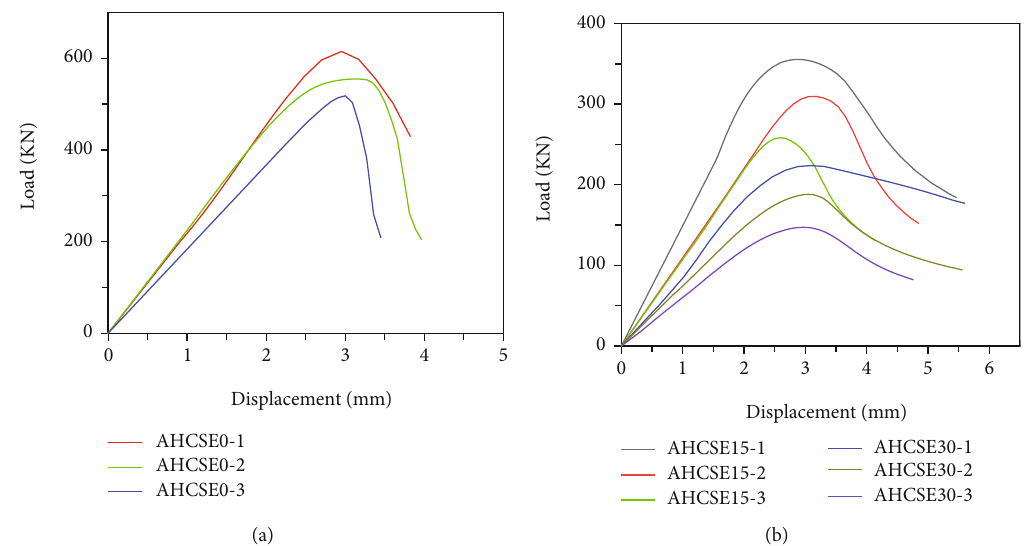
Figure 4: Load-displacement curve: (a) axial compression specimen; (b) eccentric compression specimen.